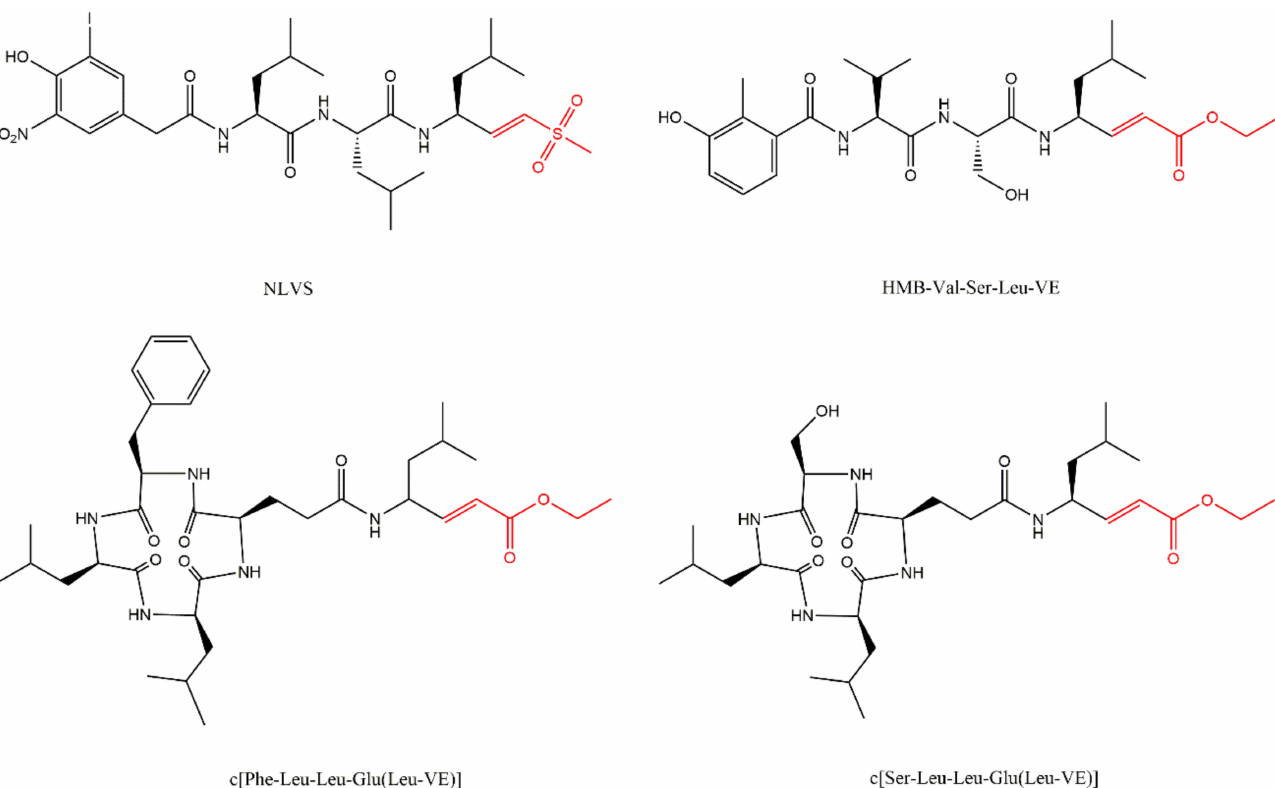
Figure 16. Example of vinyl sulfone inhibitor (NLVS) and vinyl esters inhibitors, 2 cyclics (c[Phe-Leu- Leu-Glu(Leu-VE)] and c[Ser-Leu-Leu-Glu(Leu-VE)], which present more selectivity for β 5 and β 1 subunits, respectively)